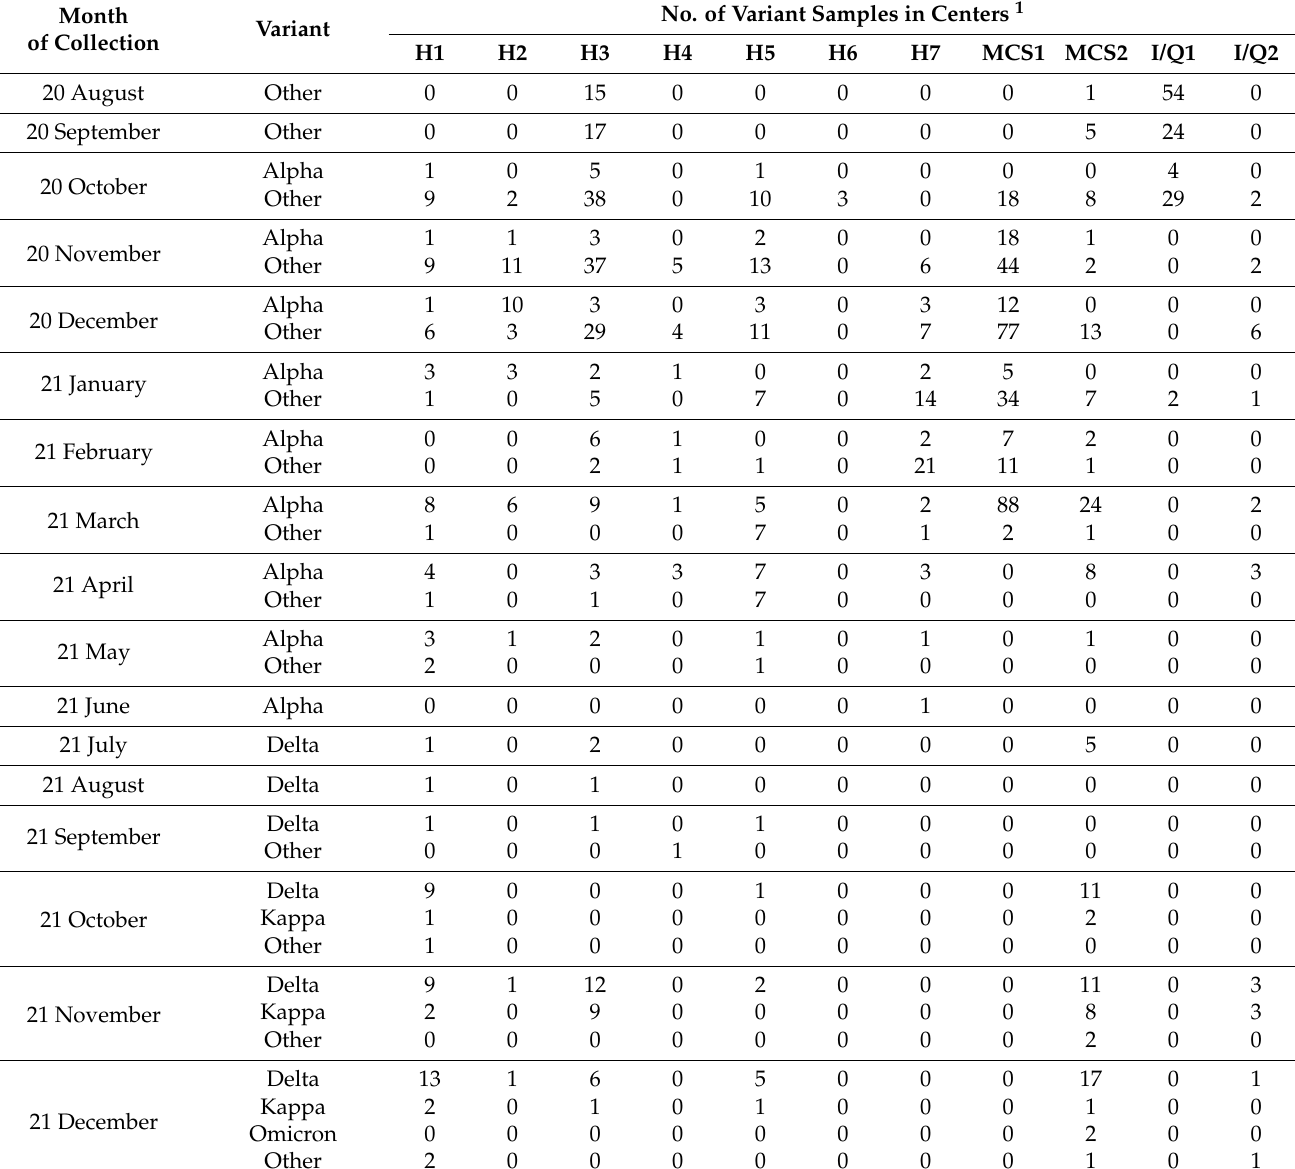
Table 4. The monthly prevalence of SARS-CoV-2 variants in particular